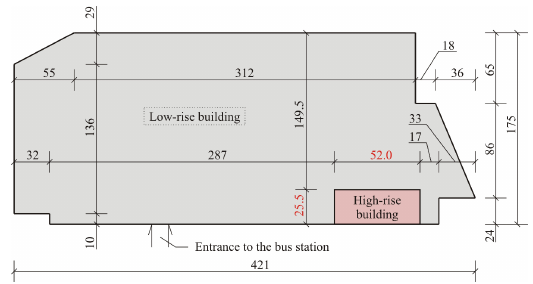
Figure 1. Ground plan of a construction pit with dimensions 420 × 175